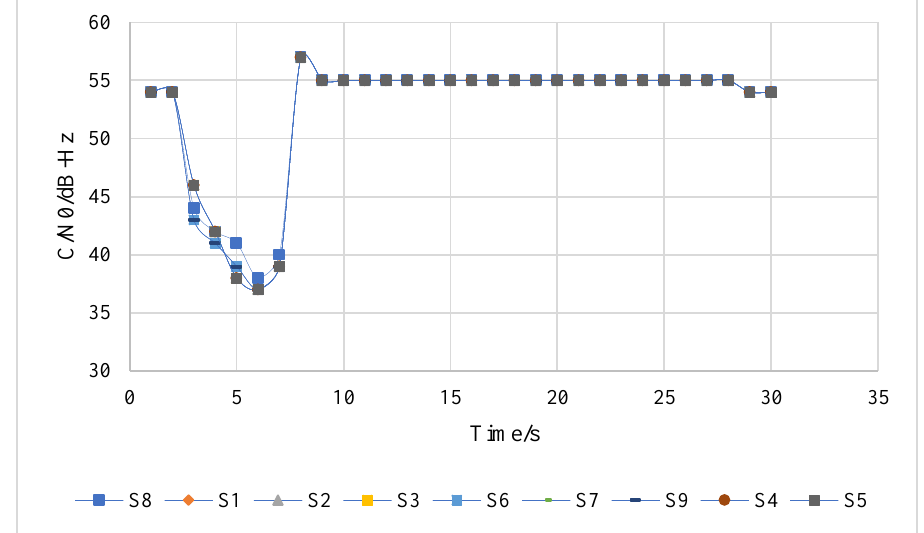
Figure 2. The process of C/N0 recovery when the interference frequency offset is 9 MHz.